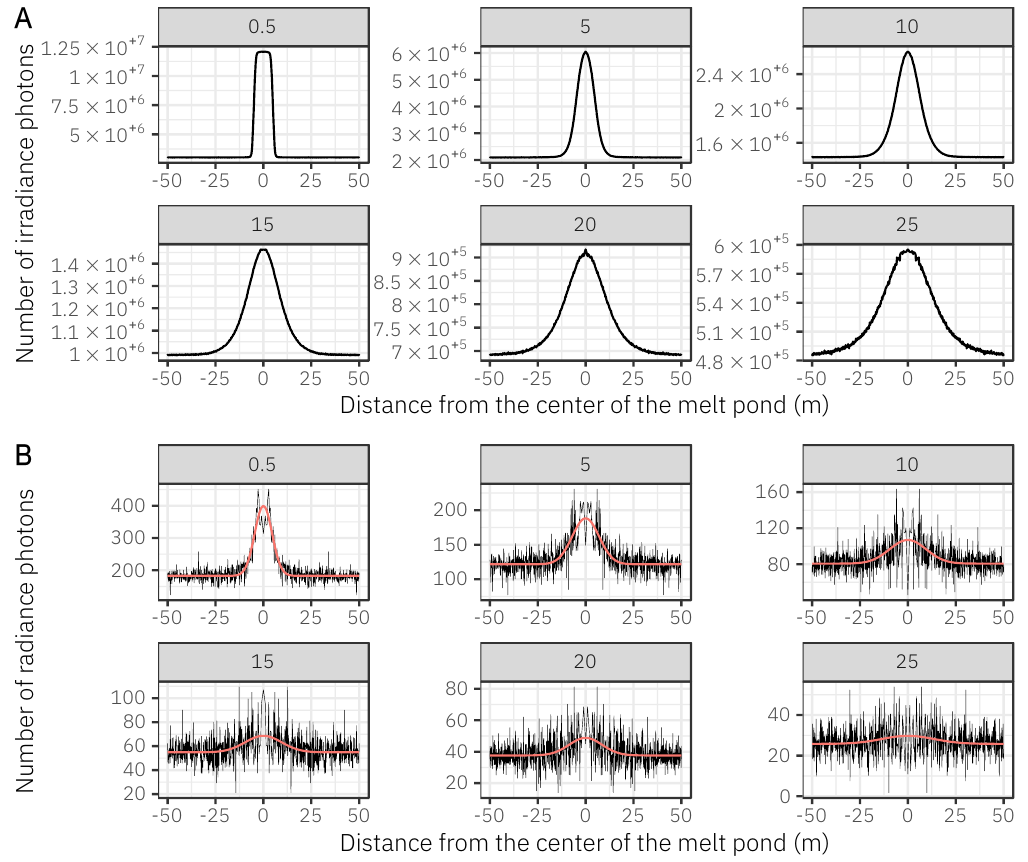
Figure A2. Examples showing the number of downward irradiance ( A ) and upward radiance ( B ) photons captured by the detectors of the Monte Carlo simulation at different depth ranges (numbers in gray boxes) as a function of the horizontal distance from the melt pond. The red lines represent the fitted Gaussian curves.